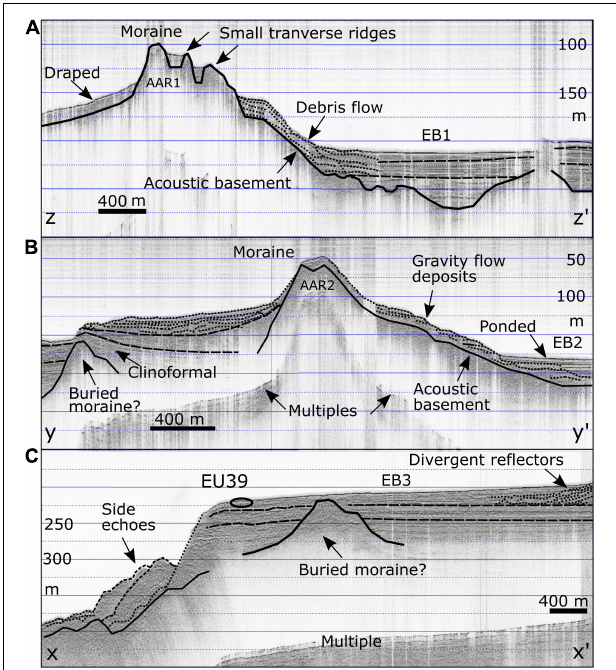
FIGURE 6 | Sub-bottom profile records from cruise NBP0505. Main seismic facies, seismic units (long segmented lines), side-echoes (short segmented lines), acoustic basements (solid lines), and other characters or processes (dotted lines) are showed. (A) Proximal subarea for the inner fjord area as showed in Figure 3A (z- z’). (B) Medial subarea for the inner fjord area as showed in Figure 3B (y-y’). (C) Distal subarea showed in Figure 3C (x-x’). Projected location of the EU39 sediment core is